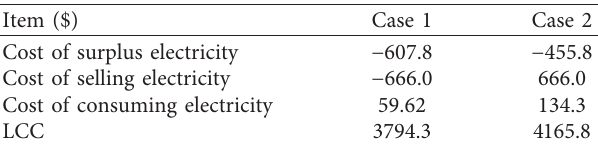
Table 12: LCC of PVAC operating on the mode of shifting peak electricity load for the